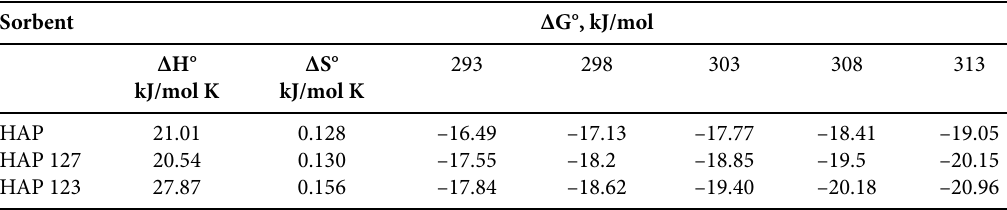
Table 2. Thermodynamic parameters of the adsorption process of Al(III) ions. Sorbent